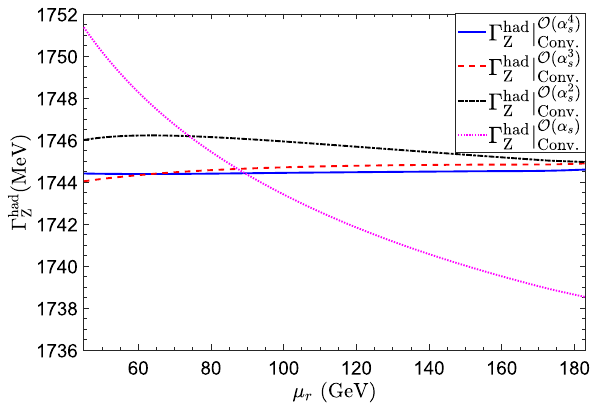
Fig. 1 The Z -bosonhadronicdecaywidth (cid:4) had scale-setting approach versus the renormalization scale μ r . The dotted, the dashed-dot, the dashed and the solid lines are for the predictions up to O (α s ) , O (α 2 s ) , O (α 3 s ) , O (α 4 s ) order levels, respectively